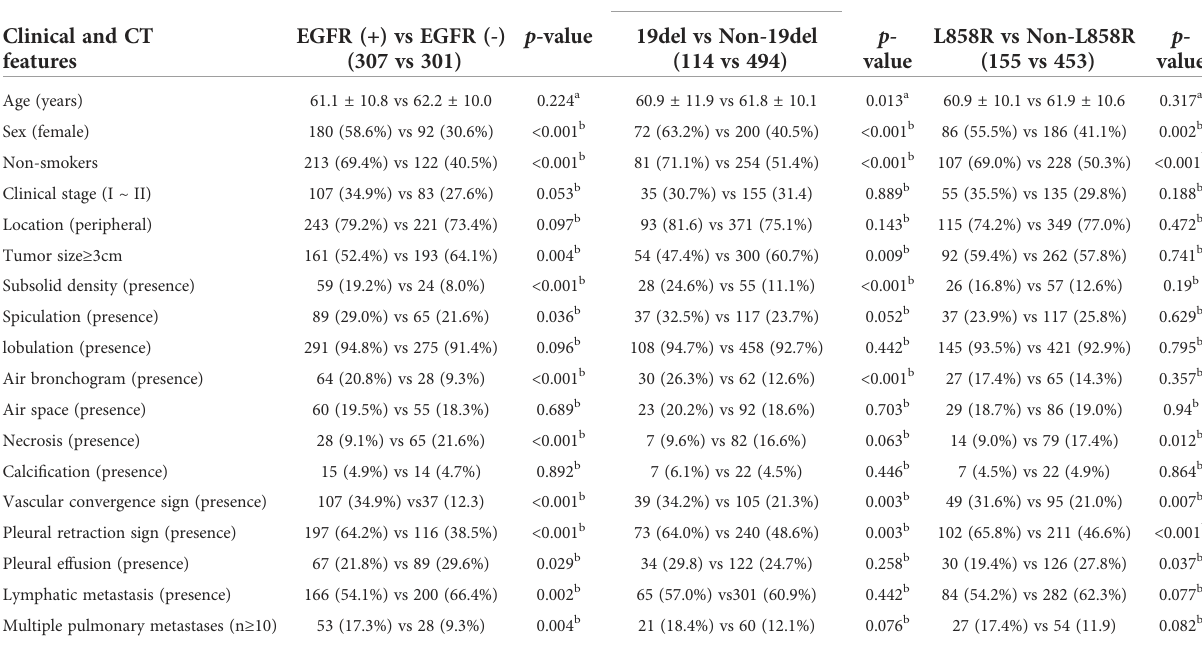
EGFR-mutation statuses